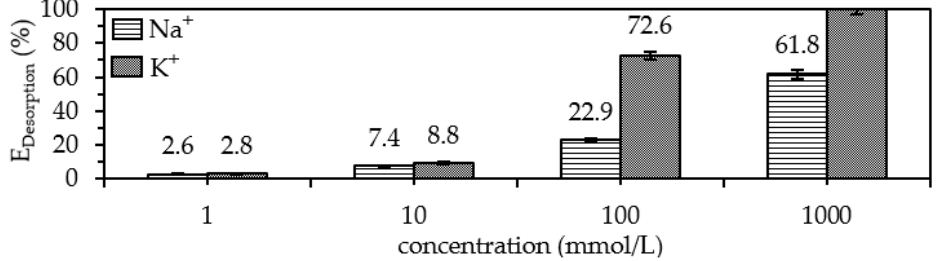
Figure 7. Regeneration efficiencies using Na + and K + ions at different molar concentrations following a single sorption step (matrix: ultrapure water; t eq : 14 d; pH 0 : 5.9; c 0 (Na + , K + ) = 1–1000 mmol/L; w / v = 100 g Z /L; T = 22 °C; grain size: 8–16 mm; n = 3).